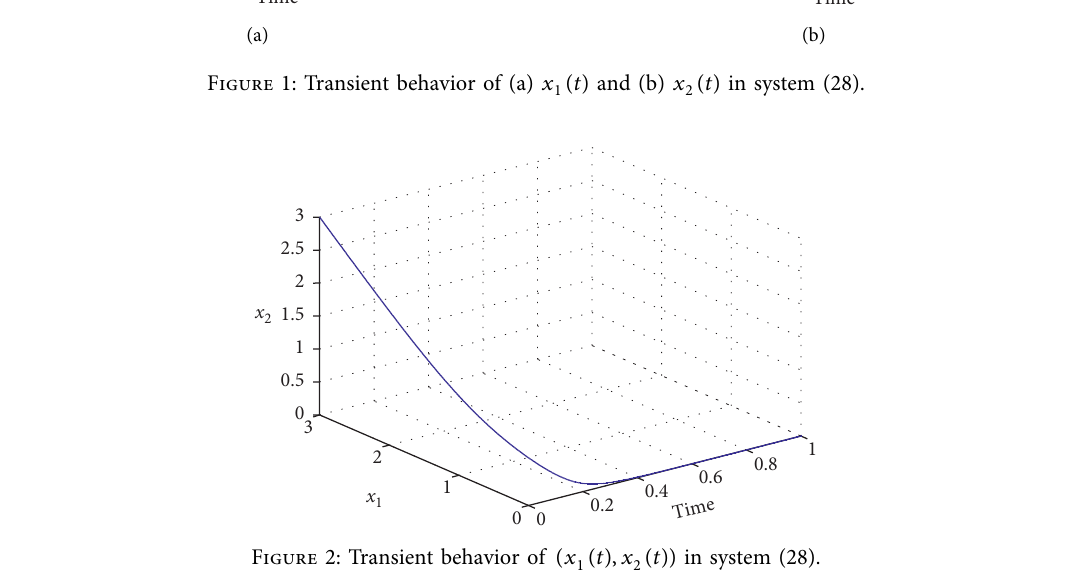
Figure 2: Transient behavior of ( x